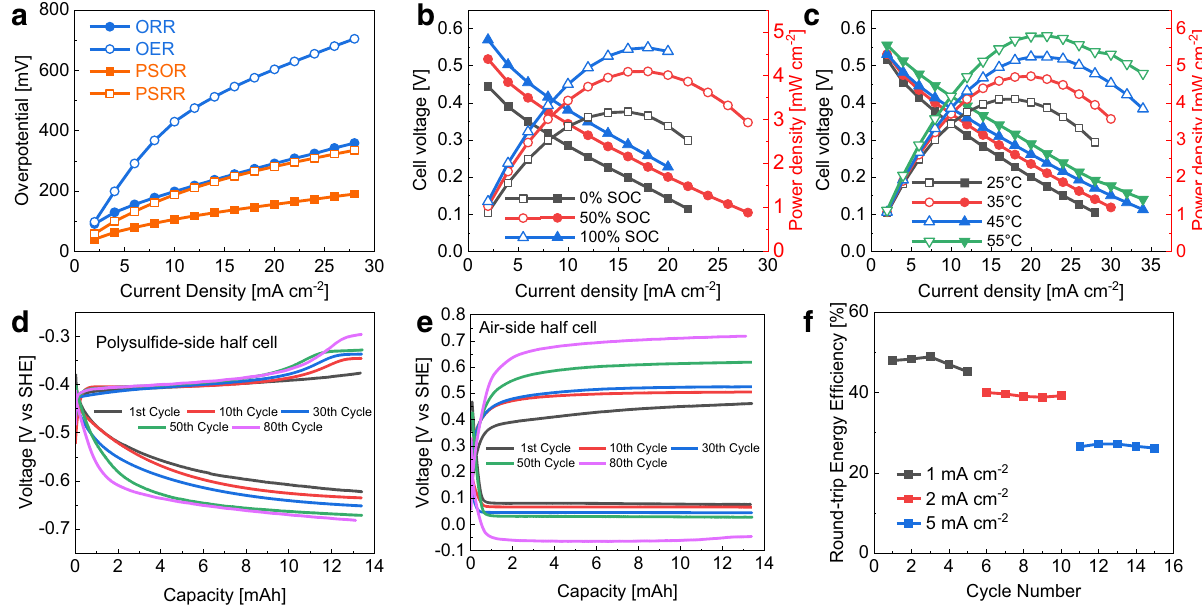
Fig. 5 Polarisation curve measurement and cycling performance of the alkaline PSA RFB with dual membranes. a Polarisation curve and power density curve at 25 °C and various SOc. b Polarisation curve and power density curve at 50% SOC and various temperatures. c Measured half-cell overpotentials against current density at 25 °C and 50% SOc. d measured polysul fi de-side half-cell potential pro fi le against capacity. e Measured air-side half-cell potential pro fi le against capacity. f Round-trip energy ef fi ciency against current